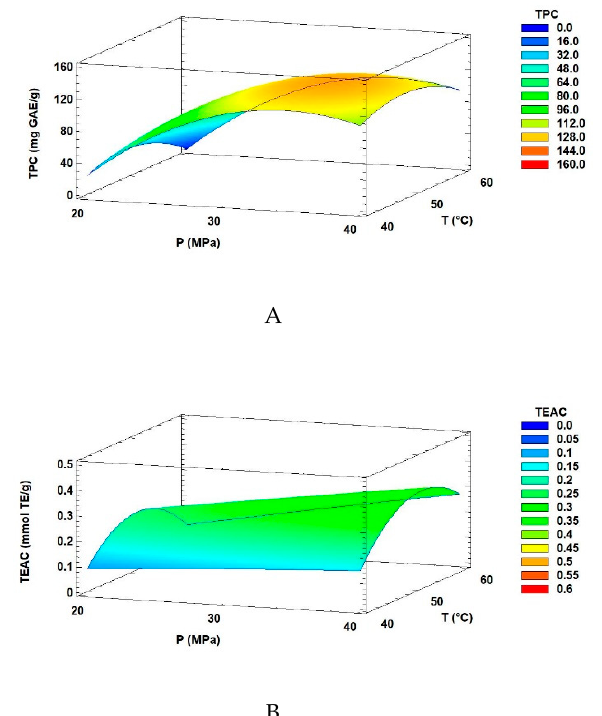
Figure 4. Response surface plot showing combined effects of pressure and temperature on (A) phenol content (TPC) and (B ) TEAC method from I. galbana . All extractions were done with 8% co-solvent (ethanol, v/v).